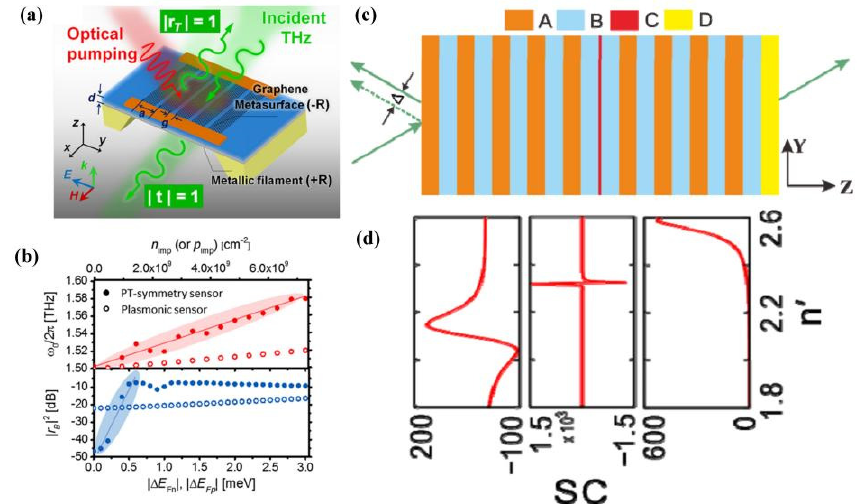
Figure 12. ( a ) Schematic integration of a PT–symmetric system. Adapted with permission from Ref. [144]. Copyright (2016), American Physical Society. ( b ) Frequency of the r B dip and the value of the exceptional point (bottom) as a function of the dopant concentration for the graphene–based PT– symmetric sensor. ( c ) Non − Hermitian multilayer media structure based on GH displacement, where A and B are the primitive unit–cell layer, C presents graphene layer and D is dielectric layer. Adapted with permission from Ref. [159]. Copyright (2018), Optical Society of America. ( d ) Correlation between sensitivity coefficient and real part of D–layer RI. Table 2. Examples of EP biosensors.